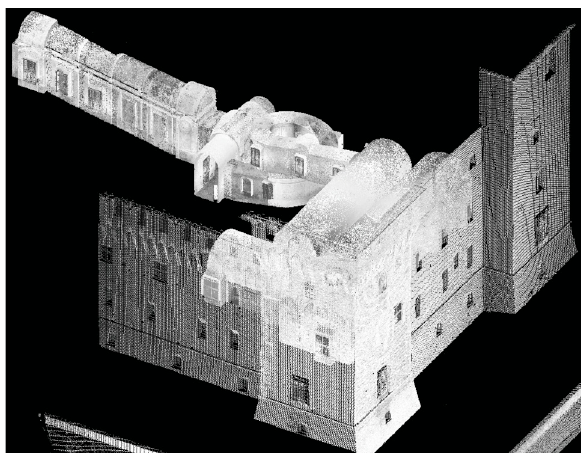
Figure 12. Whole point cloud